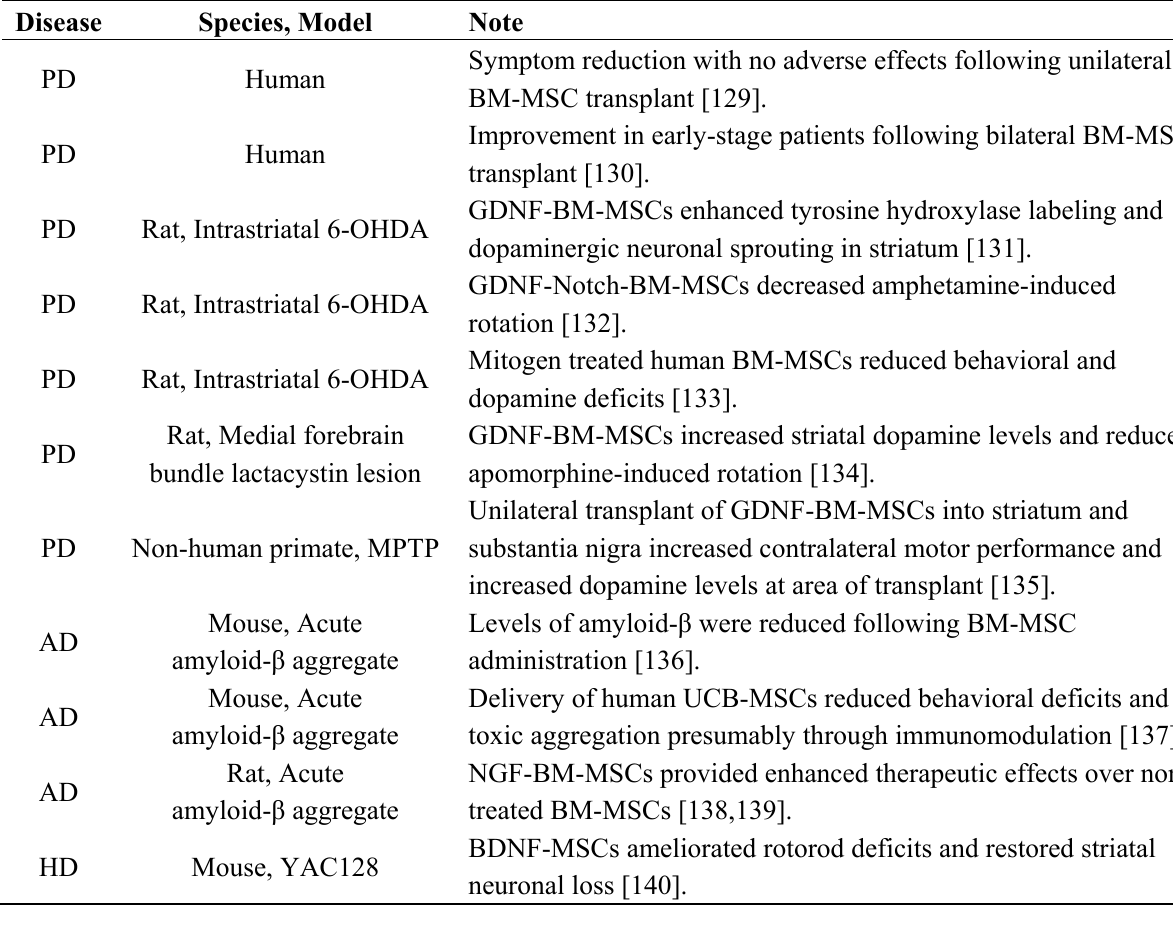
Table 1. Selected studies utilizing MSCs for the treatment of neurodegenerative diseases.